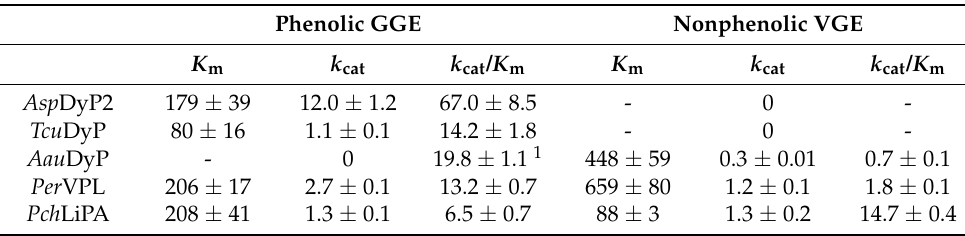
Table 2. Steady-state kinetic parameters − K m ( µ M), k cat (s − 1 ) and k cat / K m (s − 1 · mM − 1 ) − for the oxidation of GGE and VGE lignin model dimers by bacterial Asp DyP2 and Tcu DyP and fungal Aau DyP, Per VPL and Pch LiPA. Phenolic GGE Nonphenolic VGE K m k cat k cat / K m K m k cat k cat / K m Asp DyP2 179 ± 39 12.0 ± 1.2 Tcu DyP 80 ±